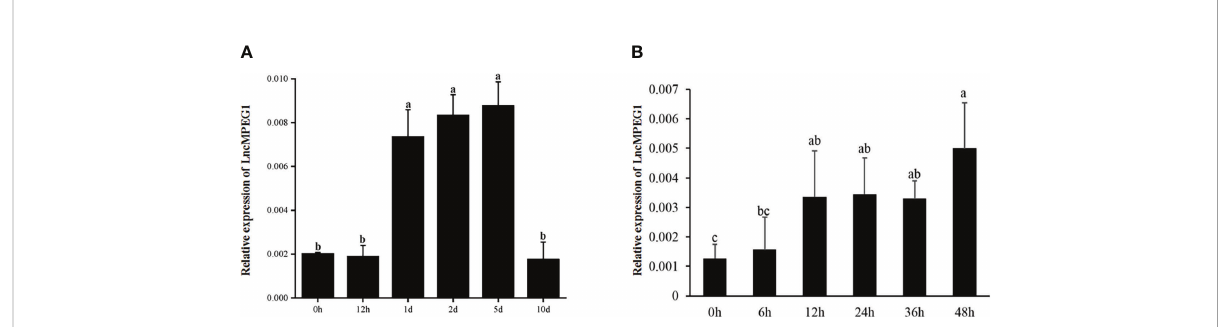
FIGURE 7 The relative expression of LncMPEG1 due to powder stimulation and shell damage. (A) the sequential expression of LncMPEG1 in the mantle with injected shell powder in EPS. (B) the sequential expression of LncMPEG1 in the mantle of Pinctada fucata martensii after shell damage. The mean values with different letters indicate signi fi cant differences (P <